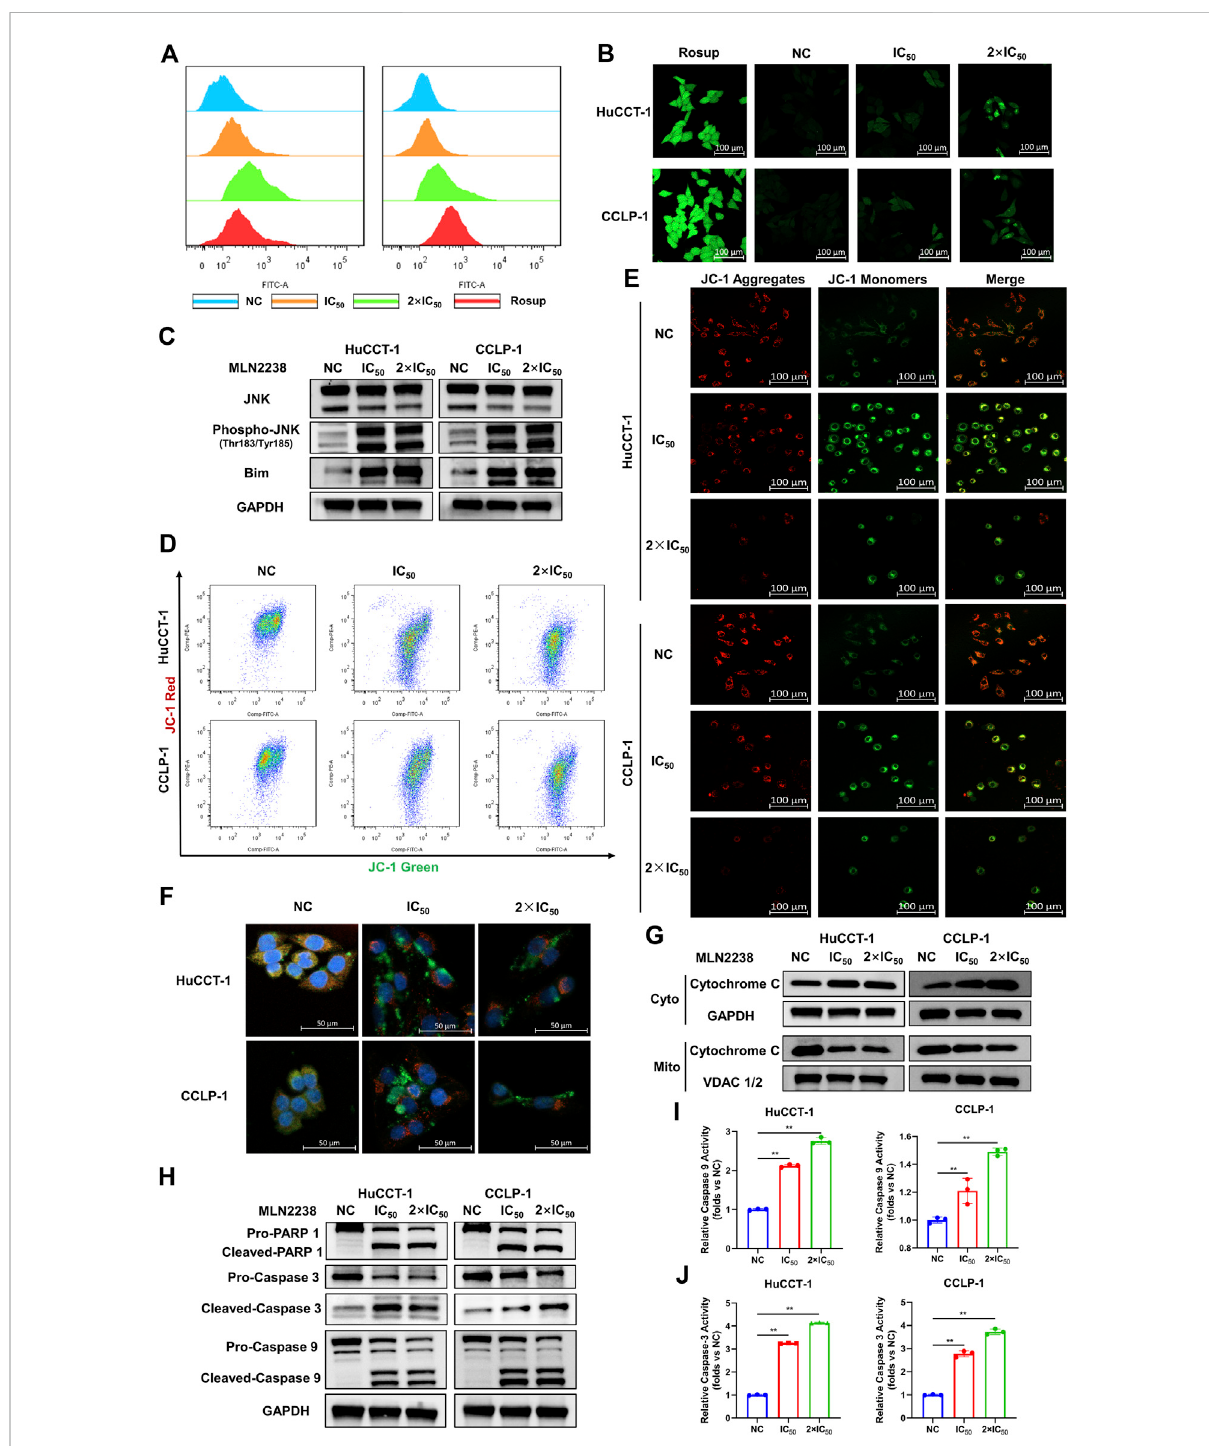
FIGURE 6 MLN2238 induced apoptosis via ROS/JNK/Mitochondrial signaling pathways in HuCCT-1 and CCLP-1 cells. ROS levels of iCCA cells after MLN2238treatment(IC50and2×IC50concentration,Rosupactedasactivecontrol)for24 hweremeasured via (A) fl owcytometryand (B)